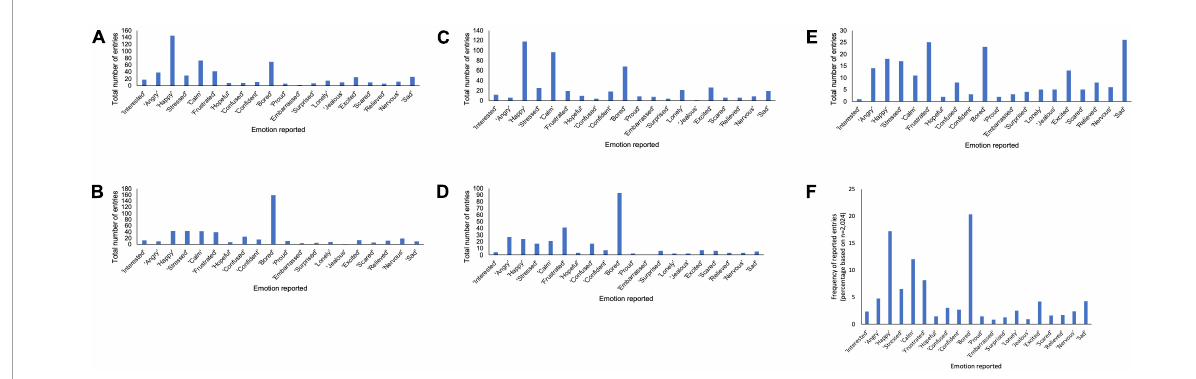
FIGURE2 (A) Sum of emotion caused by peers. (B) Sum of emotion caused by schoolwork. (C) Sum of emotion caused by self. (D) Sum of emotion caused by teacher. (E) Sum of emotion caused by other. (F) Frequency of all reported